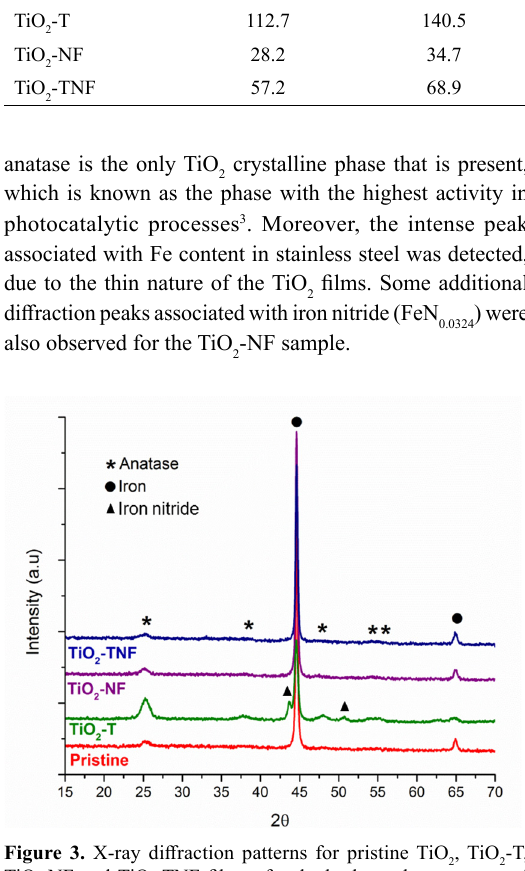
Figure 3. X-ray diffraction patterns for pristine TiO